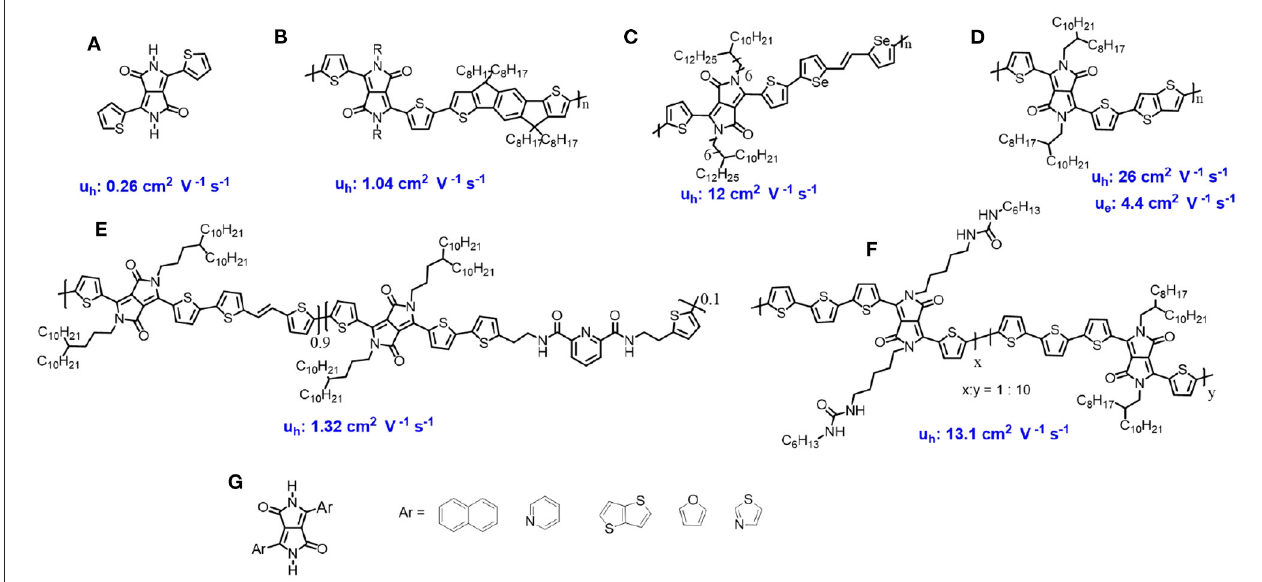
FIGURE 1 | Chemical structures of DPP-based materials for OFET and their charge transfer